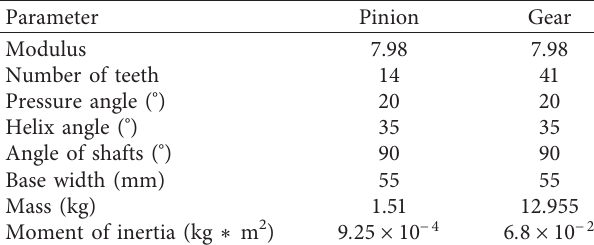
Figure 3: Diagram of spiral bevel gear pair. Table 1: Design parameters of gears.